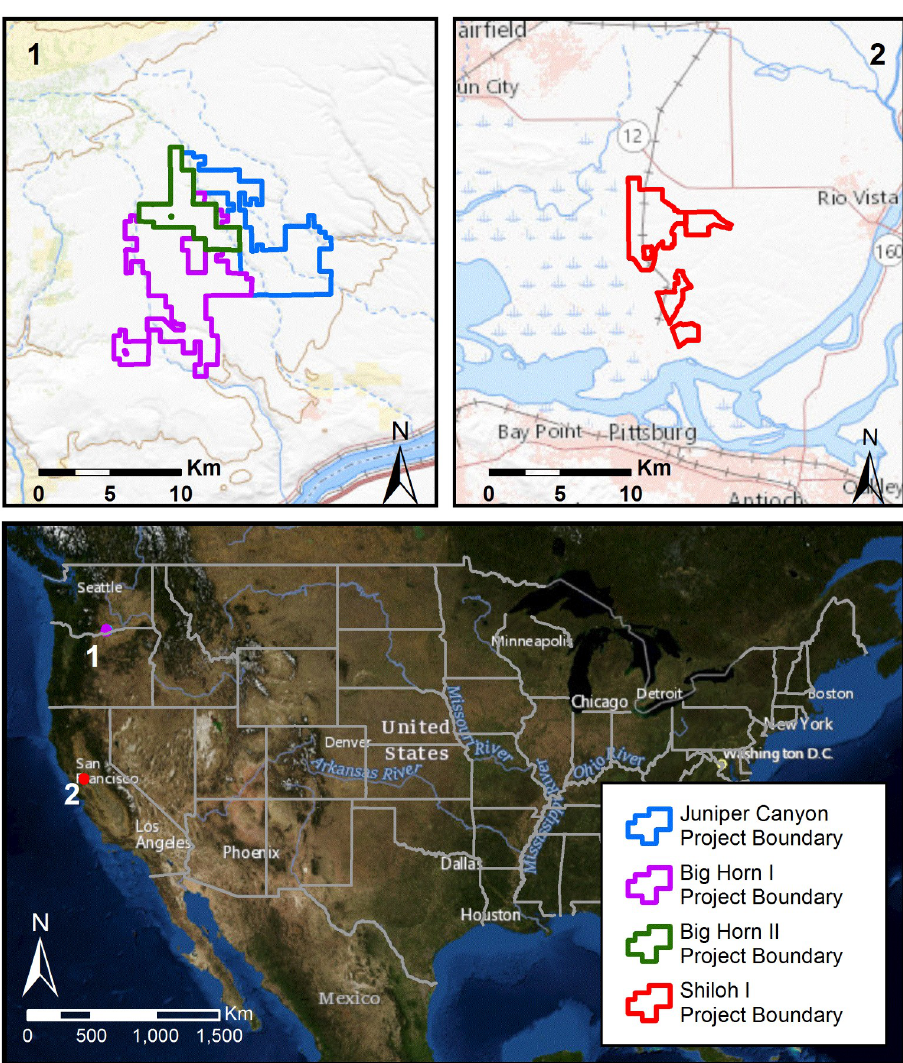
Fig 1. Locations of the Juniper Canyon, Big Horn I, and Big Horn II wind energy facilities in Washington, USA, and the Shiloh I wind energy facility in California,